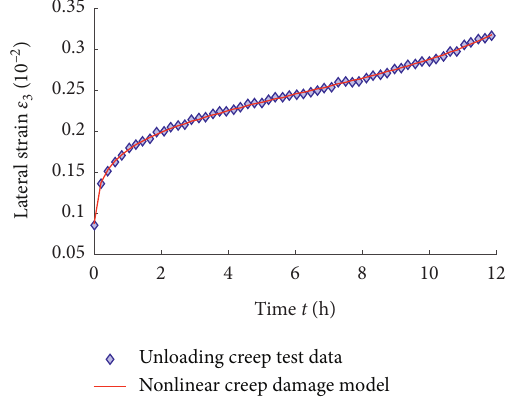
Figure 17: Fitting curve of constant deviatoric stress unloading of confining pressure and nonlinear creep model.